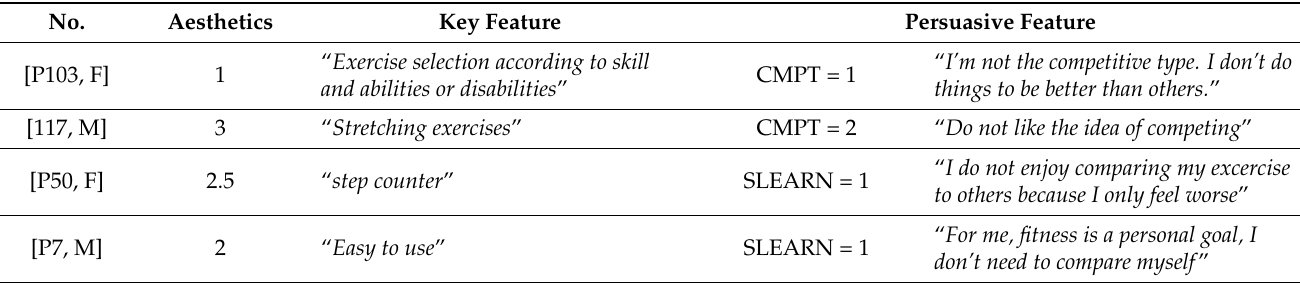
Table 11. Sample comments on the relationship between perceived aesthetics and non-receptiveness to Competition and Social Learning, CMPT = Competition, SLEARN = Social